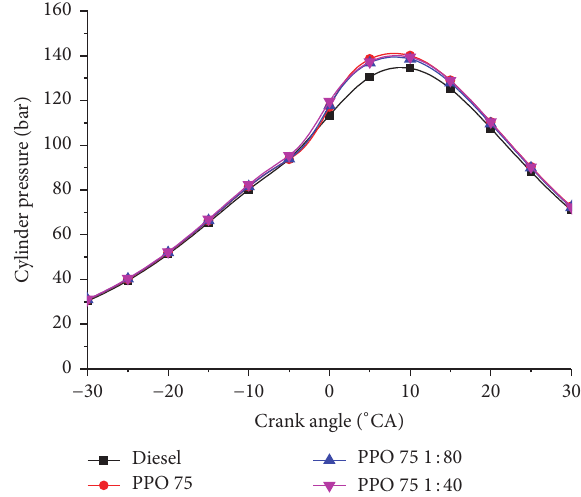
Figure 8: Variation of cylinder pressure with crank angle at 85%